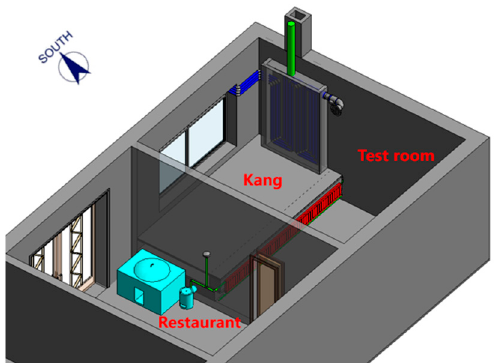
Figure 2. Design of FGFAHE experiment bench.